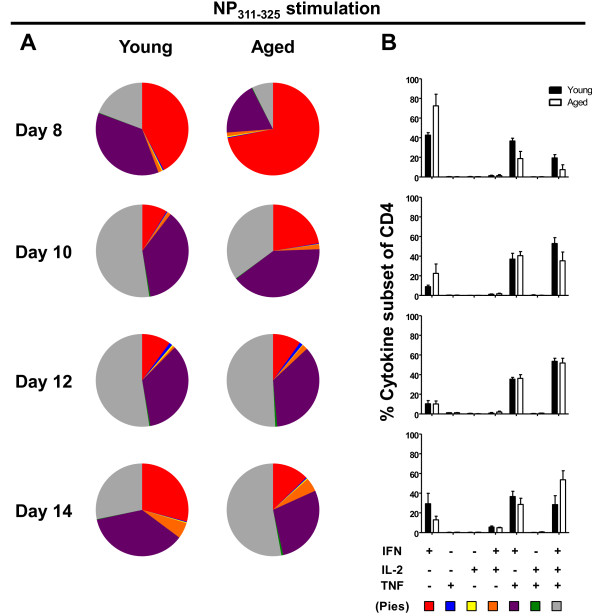
The cytokine response of influenza NP-specific CD4 T cells is delayed in aged compared with young mice. Lung airway cells obtained by bronchoalveolar lavage from young and aged mice were analyzed at days 8, 10, 12 and 14 following i.n. infection with 3,000 EID50 ×-31 for production of cytokines following in vitro stimulation with the NP311–325 peptide. Cytokine-producing cells (IFN-γ, TNF-α and/or IL-2) within the CD4+CD44high population were divided into seven subpopulations based on their production of these cytokines in combination (refer to color code at the bottom of Panel B). The relative contribution of each of these subpopulations to the responding T cell population was determined as depicted in the pie charts in panel A. The bar charts in panel B show the frequency of each cytokine subpopulation out of the total responding CD4 T cell population. Data are representative of 2 independent experiments with 5–8 mice per time point.